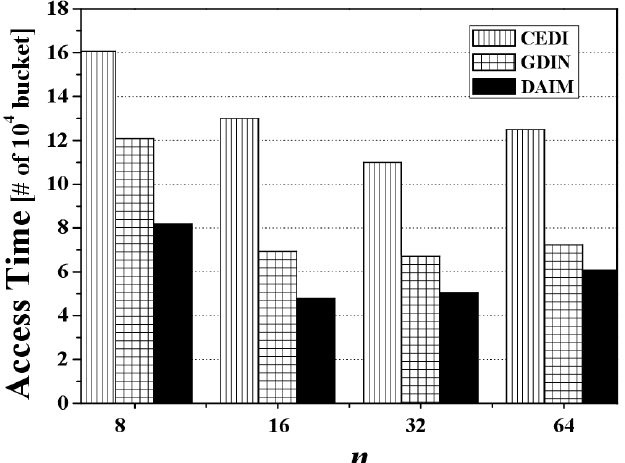
Figure 9. The comparison of the access time over various n